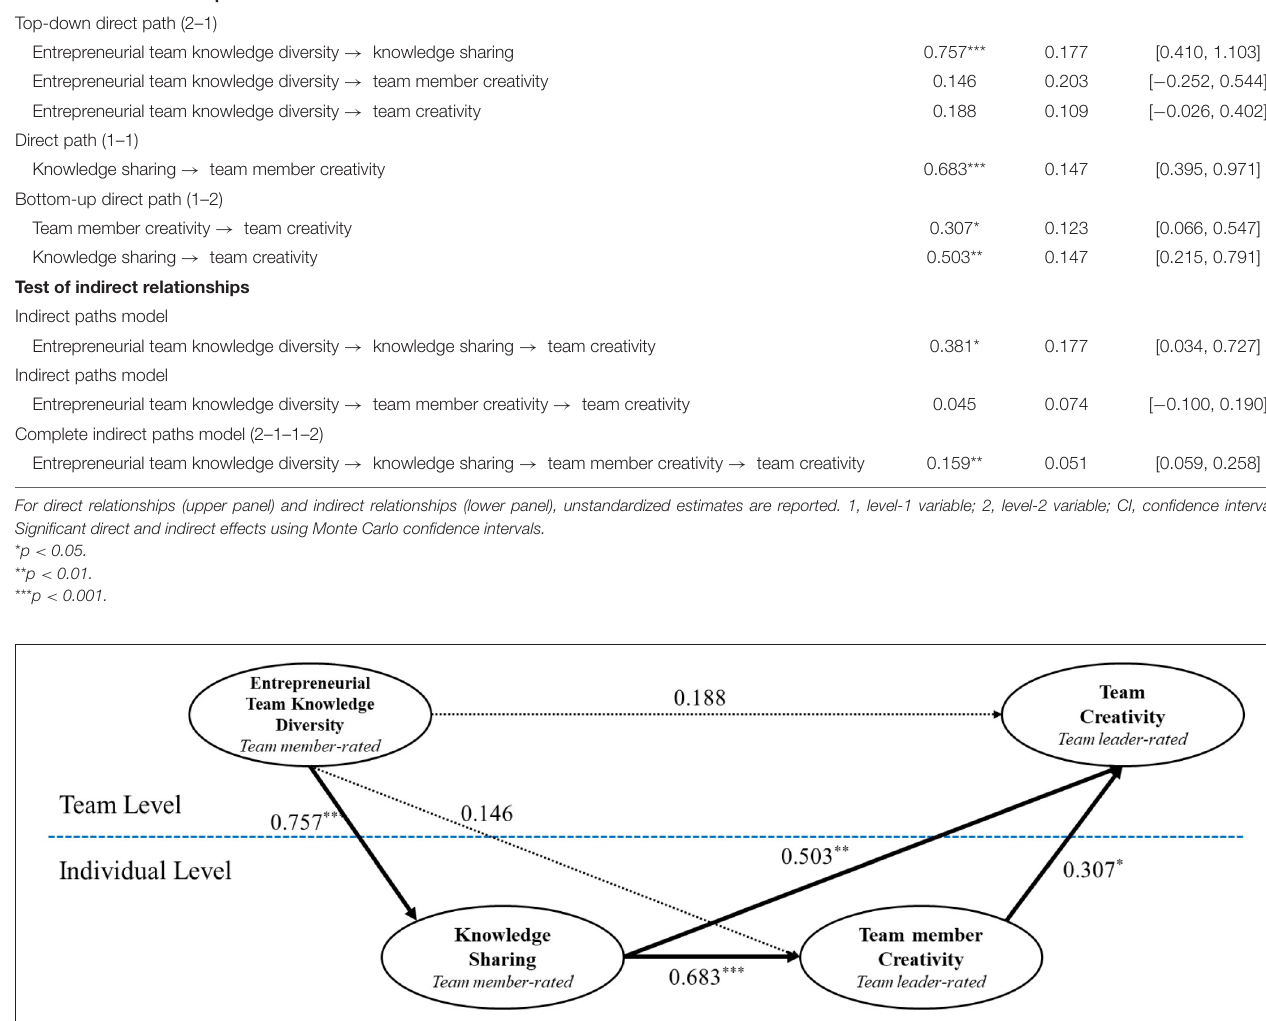
of different heterogeneity variables are not all similar.